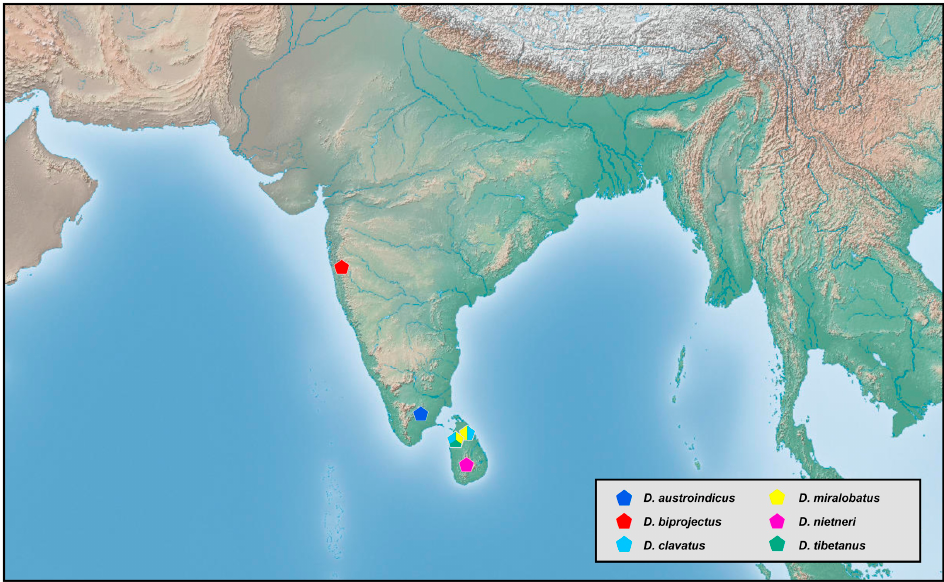
Figure 22. Distribution map of the species of Dilar from the southern part of South Asia (Region 3 in Figure 19).